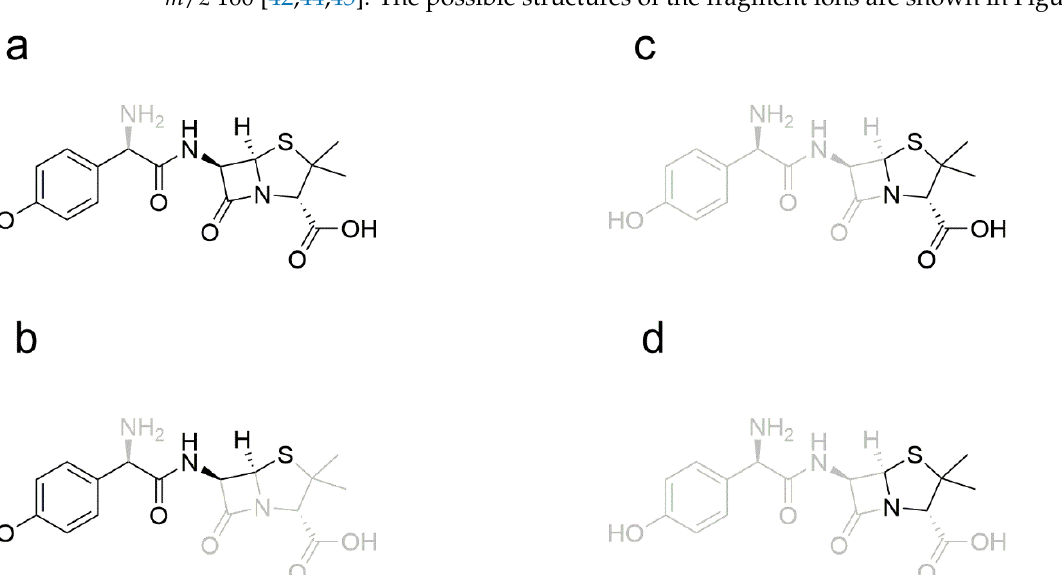
Figure 14. Two possible positions of fragment m / z 323 ions in amoxicilloic acid. Figure 15. Two possible positions of fragment m / z 189 ions in amoxicilloic acid.